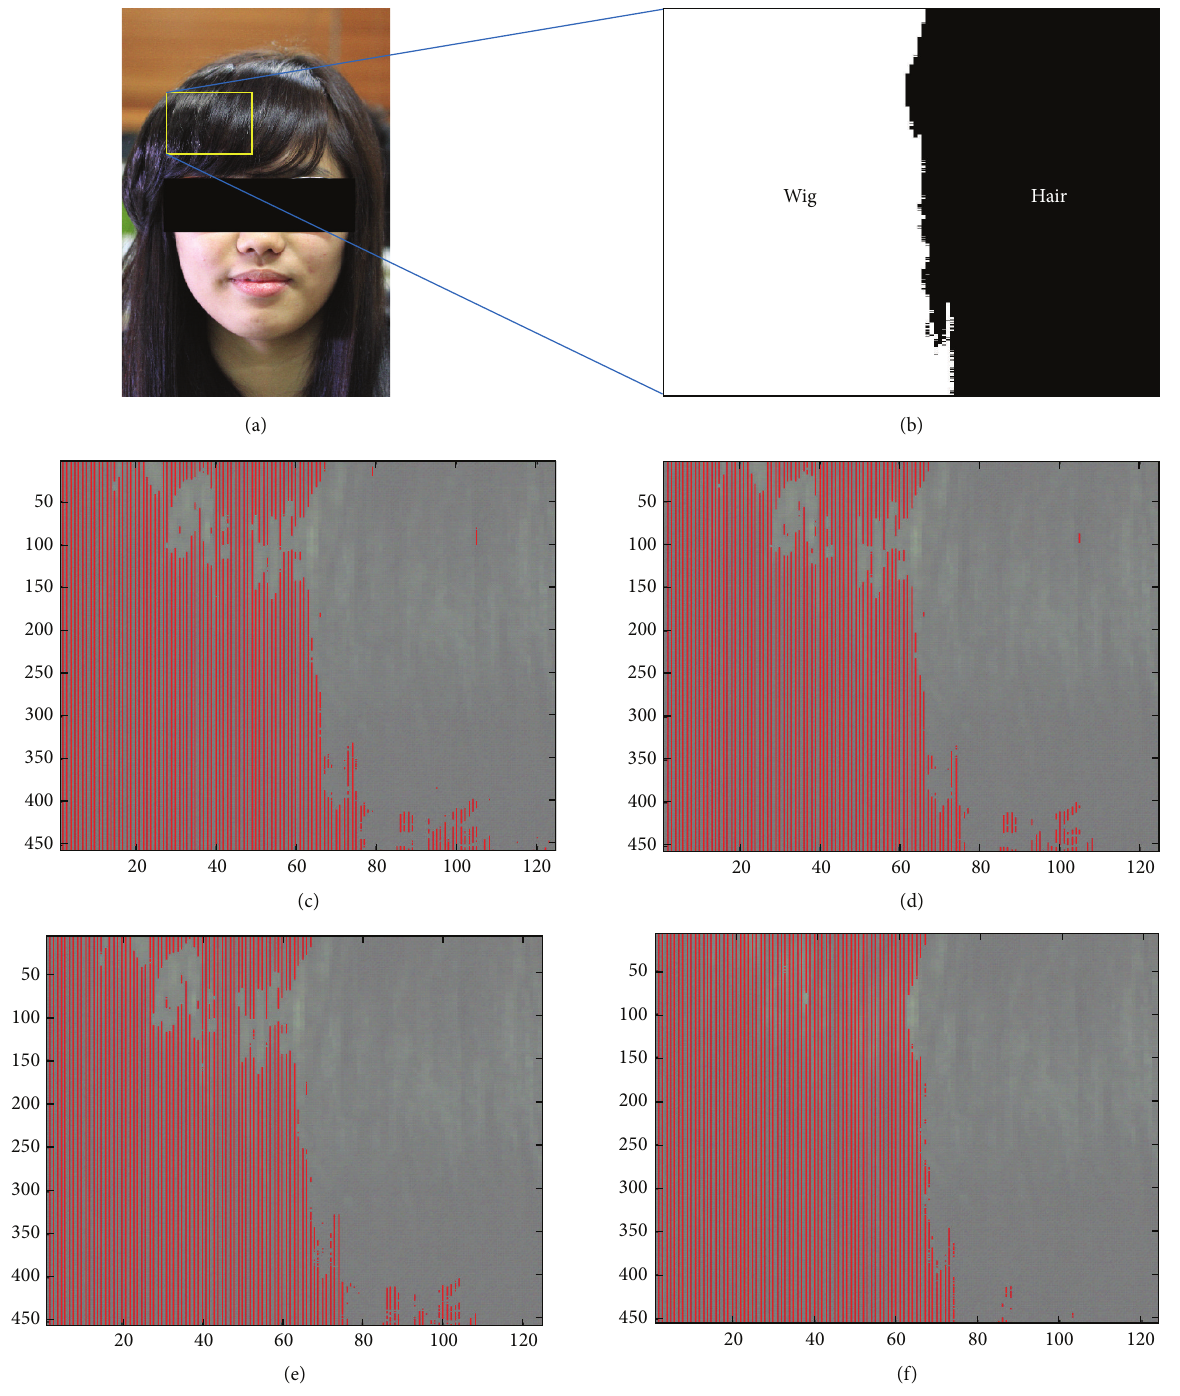
Figure 8: Abnormal region detection results: (a) test hair image, (b) ground truth, (c) PCA method, (d) spectral profile, (e) Proposed 1 band selection by spectral analysis, and (f) Proposed 2 band selection by spectral-spatial analysis.